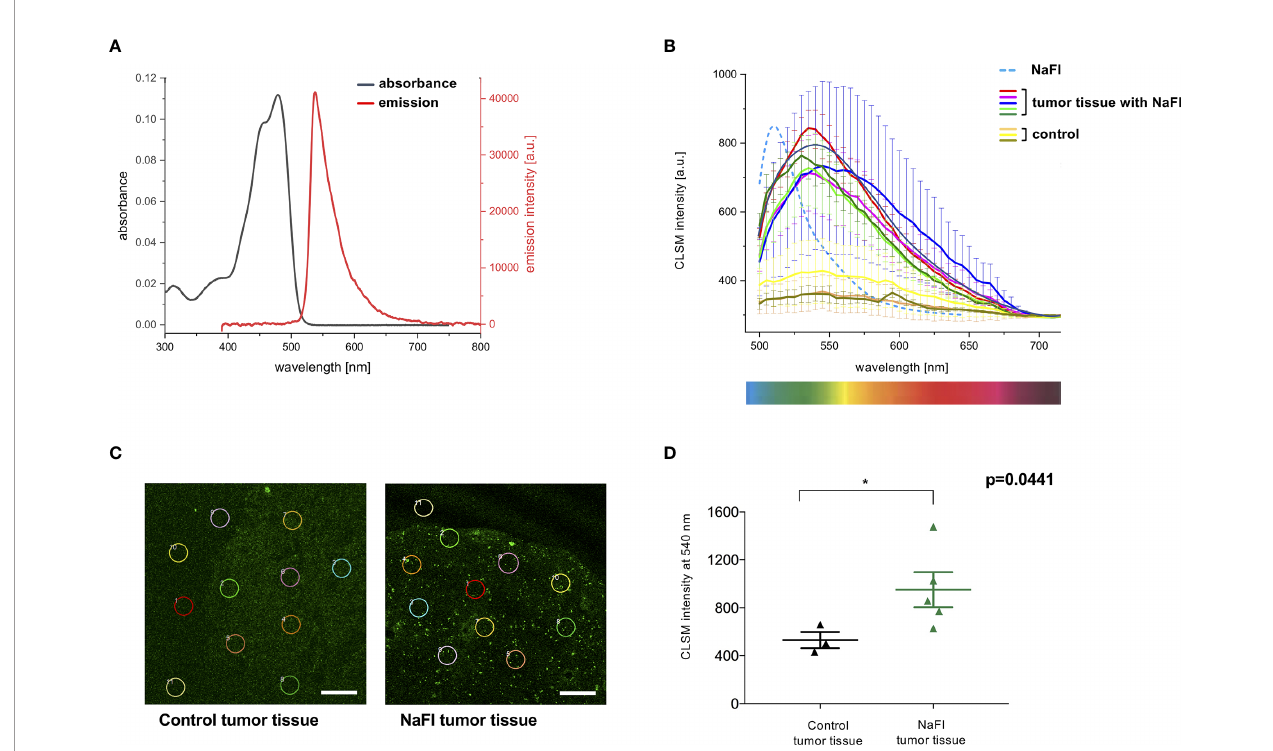
FIGURE 3 | Absorbance and emission of NaFl in vitro and ex vivo . (A) Absorbance (black line) and emission spectra (red line) under in vitro conditions show the typical maximum absorbance at l max abs = 479 nm and an emission peak at l max em = 538 nm. (B) Confocal Laser Scanning Microscopy (CLSM) emission spectra of NaFl in phosphate buffer solution at pH 8.04 in vitro (blue dashed line) and in ex vivo samples (colored solid lines). Exemplary, but representative ex vivo tumor samples with NaFl show a broadened, bathochromically shifted NaFl tumor emission (solid lines). A broad but very weak emission in the same wavelength region was also observed for the control samples. (C, D) Exemplary, but representative CLSM intensities of 10 regions of interests (ROIs) read out at 540 nm show a signi fi cantly higher signal in fl uorescein tumor samples (971.1 ± 146.1 a.u.) versus control samples (530.6 ± 67.58 a.u.); p= 0.0441. Values are expressed in average ± S.E.M. (Scale bar = 100